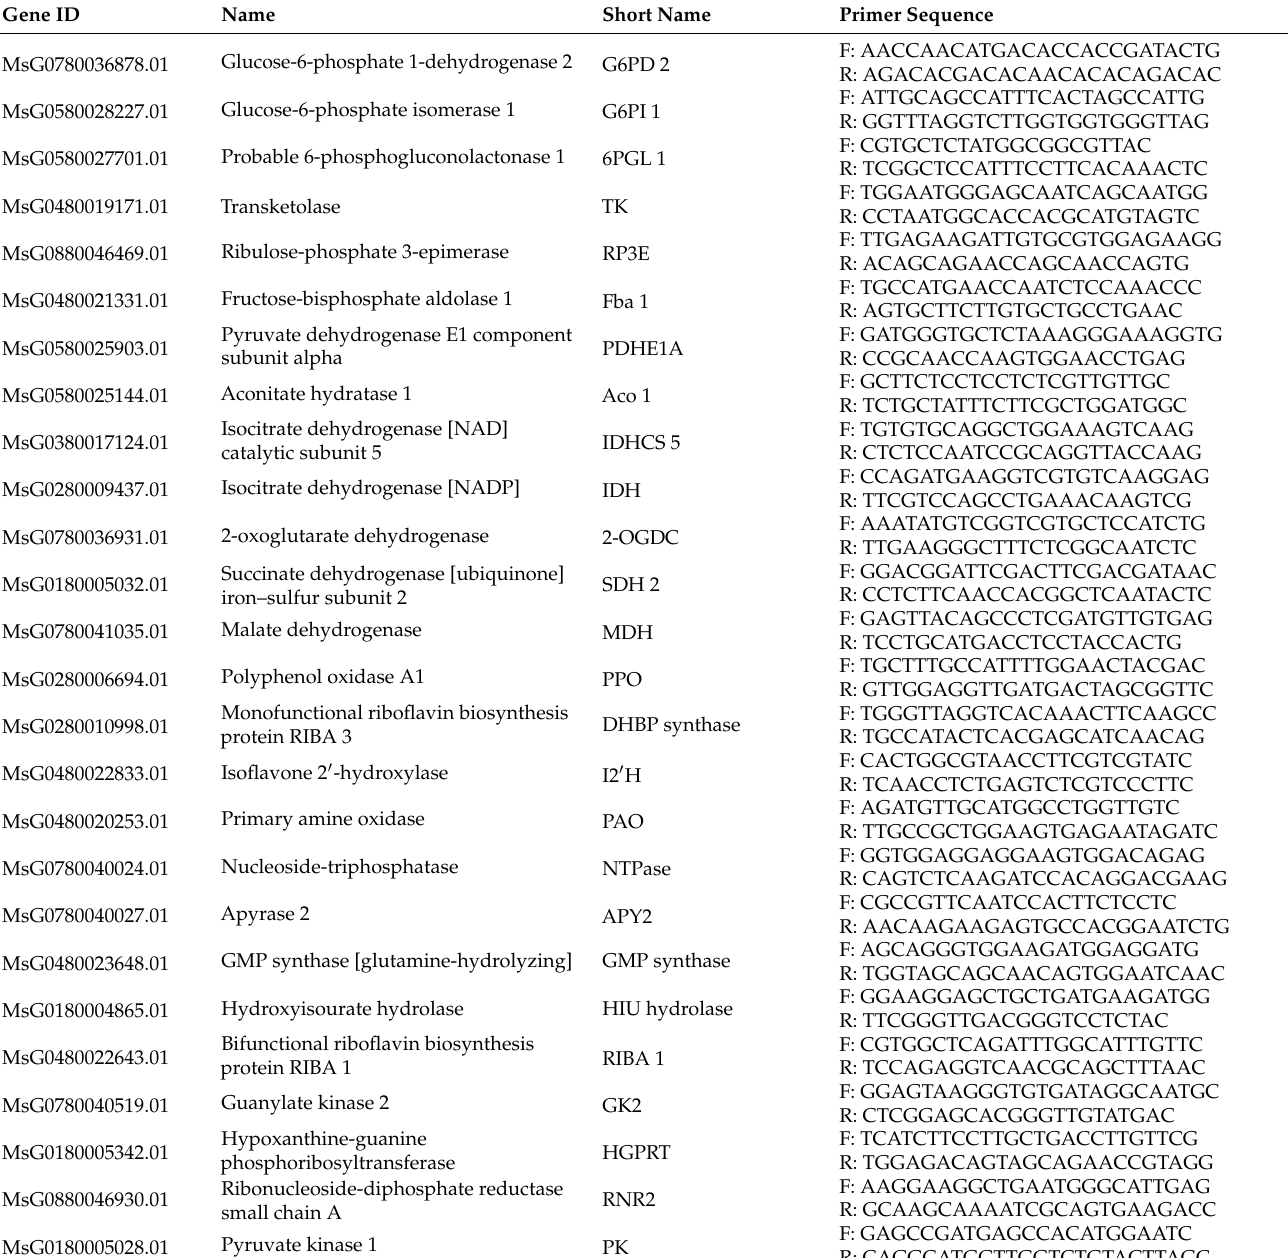
Table A1. Primers of candidate genes in